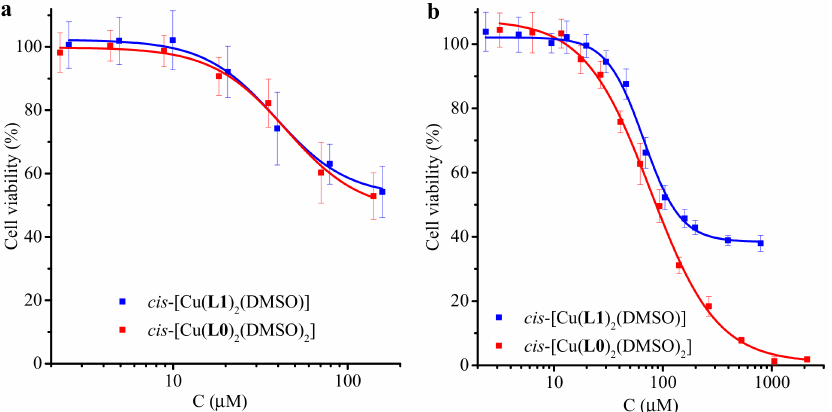
Figure 4. Vero ( a ) and HeLa ( b ) cell viability based on MTT assay following 1-day incubation in the presence of varying concentrations of test compounds. The results of MTT assay for cell lines without treatment (negative control) were taken as